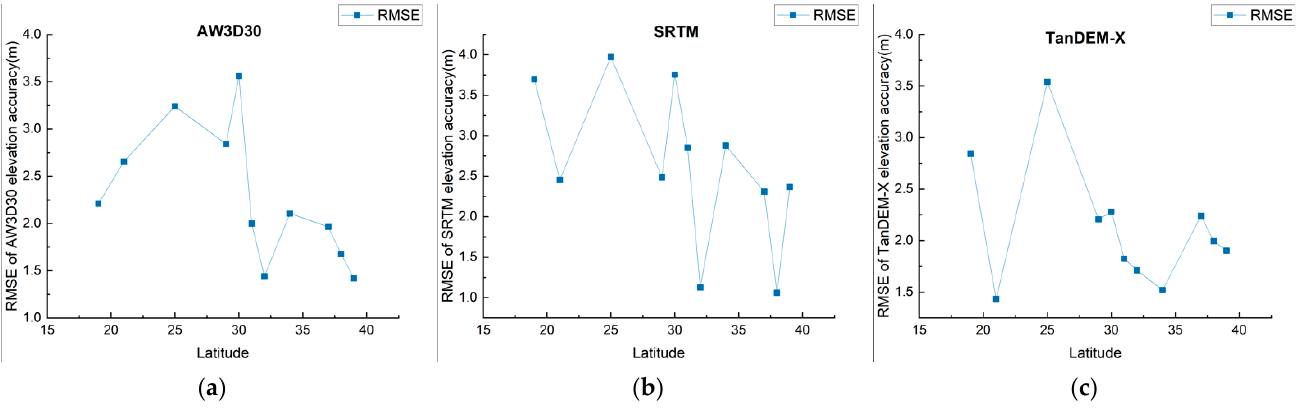
Figure 7. RMSE values of the three DEMs with respect to latitude: ( a ) AW3D30, ( b ) SRTM, and ( c ) TanDEM-X.